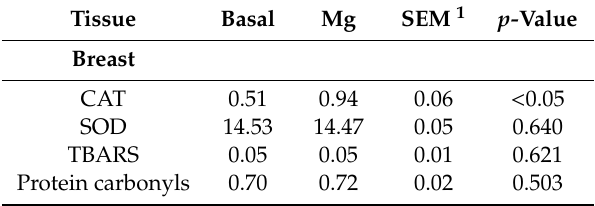
Table 4. E ff ect of the dietary treatment on catalase (CAT) and superoxide dismutase (SOD) activities (U / mg), and concentration of thiobarbituric acid reactive substances (TBARS) (mg / kg) and protein carbonyls (nmol / mg protein) concentration in tissues from experimental broilers. Tissue